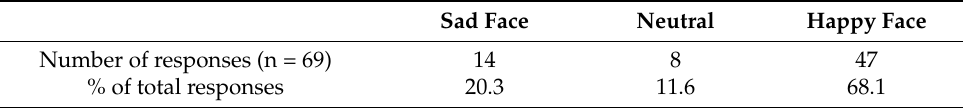
Table 3. Children’s response to finger-prick blood collection.